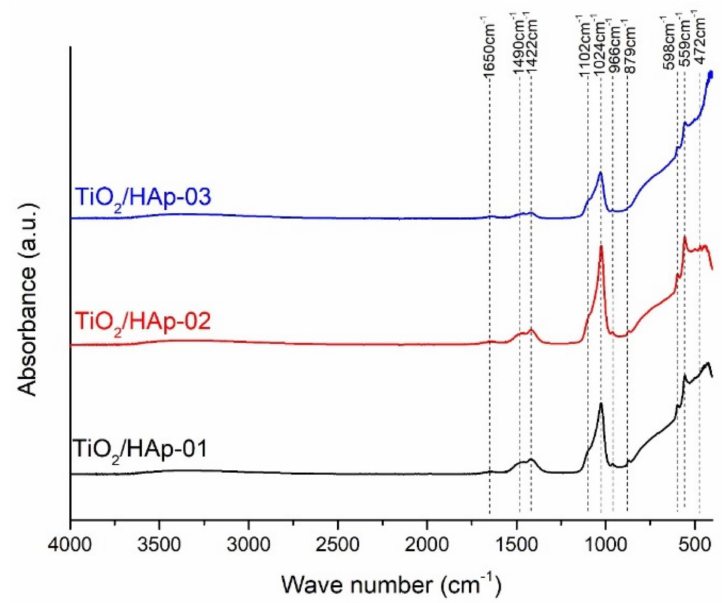
Figure 2. FTIR spectra of TiO 2 /HAp-01, TiO 2 /HAp-02, and TiO 2